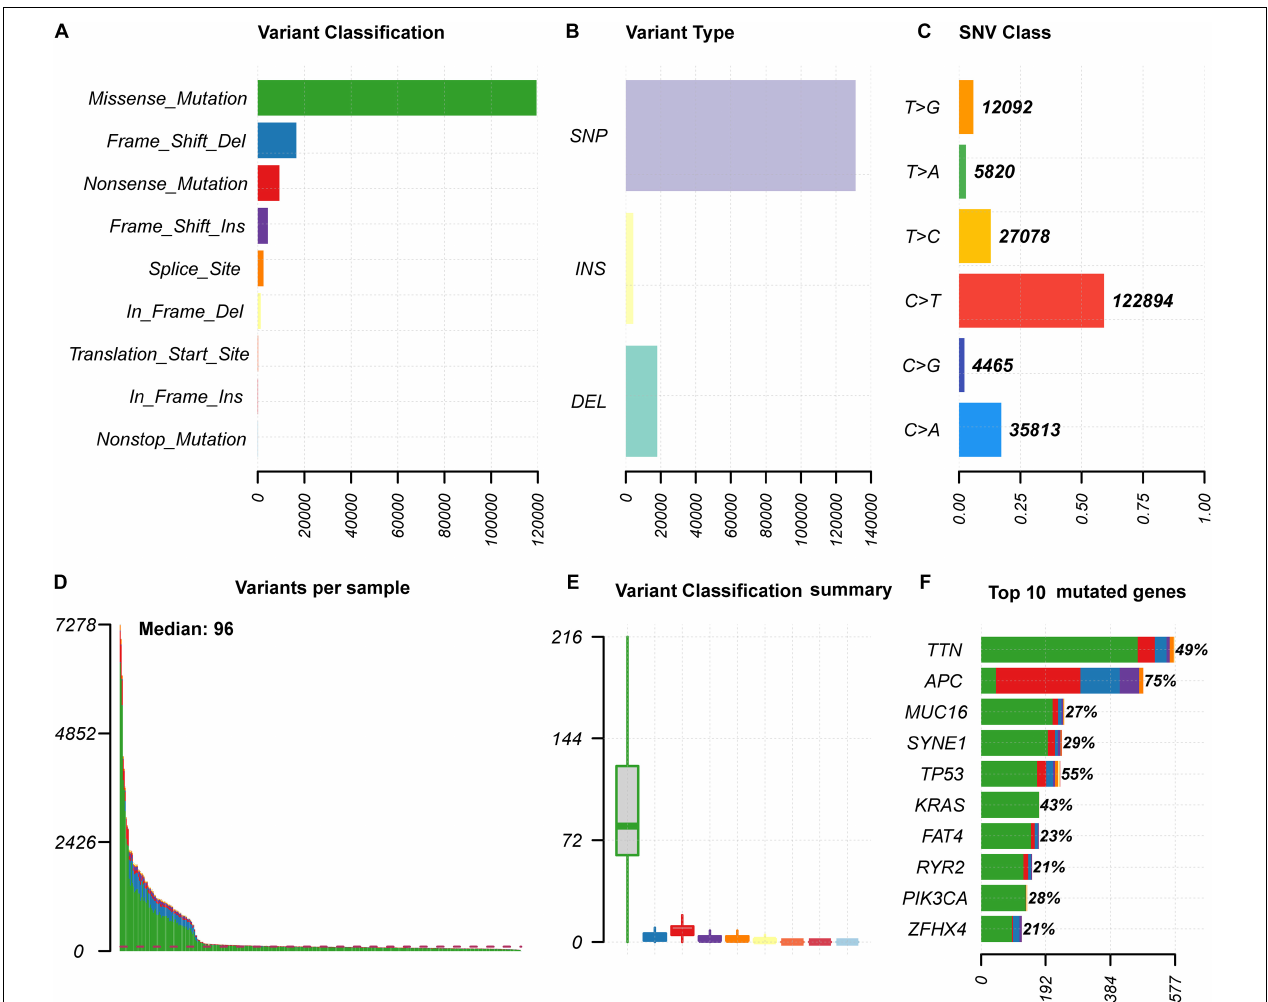
FIGURE 1 | The summary information of somatic mutation in colon cancer samples from the TCGA database. (A) Frequency of different mutation classification. (B) Frequency of mutational variant types. (C) Frequency of SNV class. (D,E) TMB level of each colon cancer samples. (F) Top 10 mutated genes in colon cancer samples. SNP, single nucleotide polymorphism; INS, insertion; DEL, deletion; SNV, single nucleotide